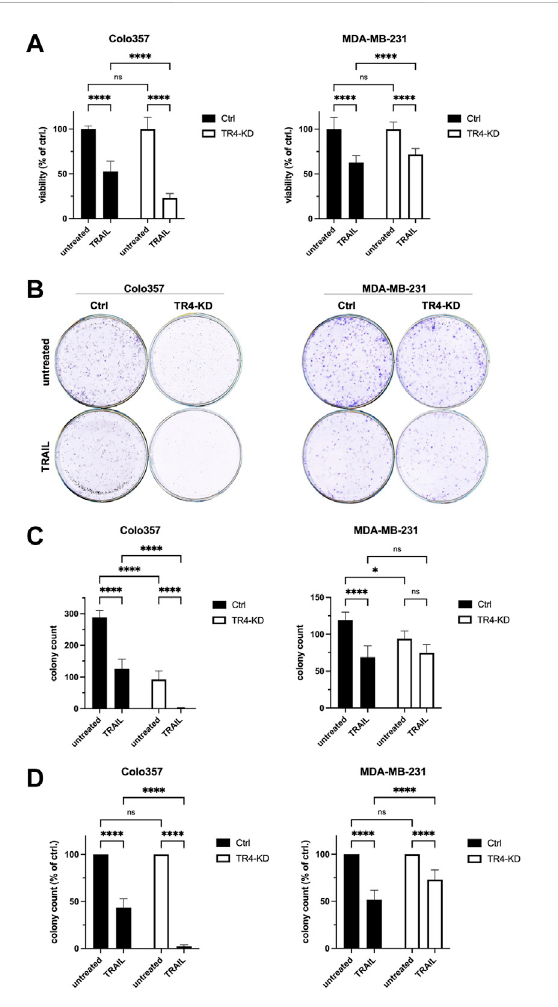
FIGURE 2 Opposite impact of TRAIL-R4 on cell viability and clonogenic survival after TRAIL treatment in Colo357 and MDA-MB-231 cells. (A) ViabilityofColo357andMDA-MB-231withandwithoutknockdownof TRAIL-R4 (TR4-KD) relative to control cells (Ctrl) analyzed by crystalvioletviabilityassay.Cellswereseededat1×10 4 cells/wellin96- well format. After 24 h cells were stimulated with TRAIL (Colo357 — 50 ng/ml; MDA-MB-231 — 100 ng/ml) for 24 h or left untreated. Subsequently, crystal violet viability assay was performed. Shown are the mean ± SD of two (Colo357) or three (MDA-MB-231) independent experiments ( n = 2, n = 3), respectively. Each experiment was performed in at least eight technical replicates. The asterisks (****/**) indicate signi fi cance ( p < 0.0001/ < 0.01). (B) Clonogenic survival assay of untreated and TRAIL-treated Colo357 and